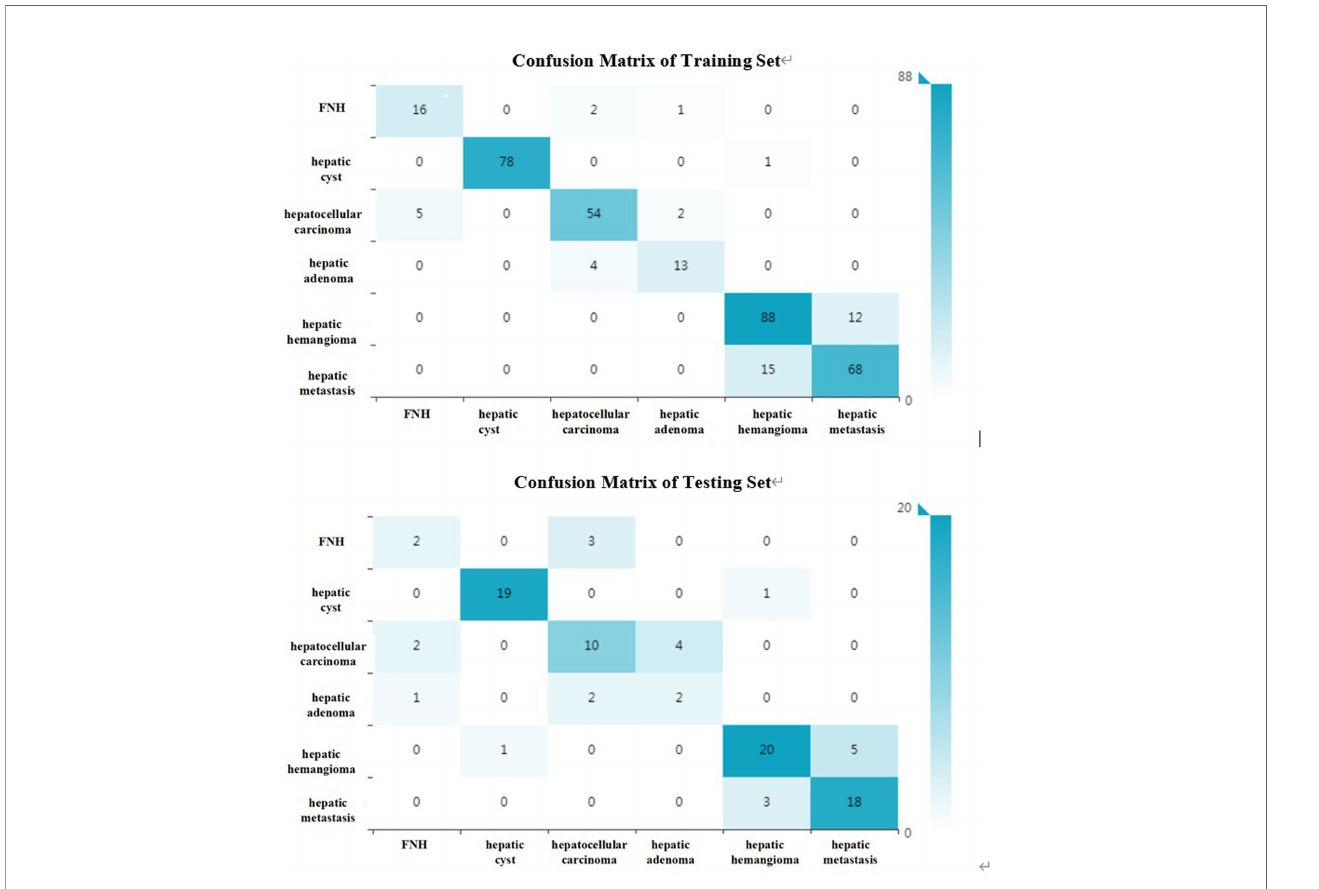
TABLE 3 | Diagnostic performance of radiomics models between benign and malignant focal hepatic lesions. Category